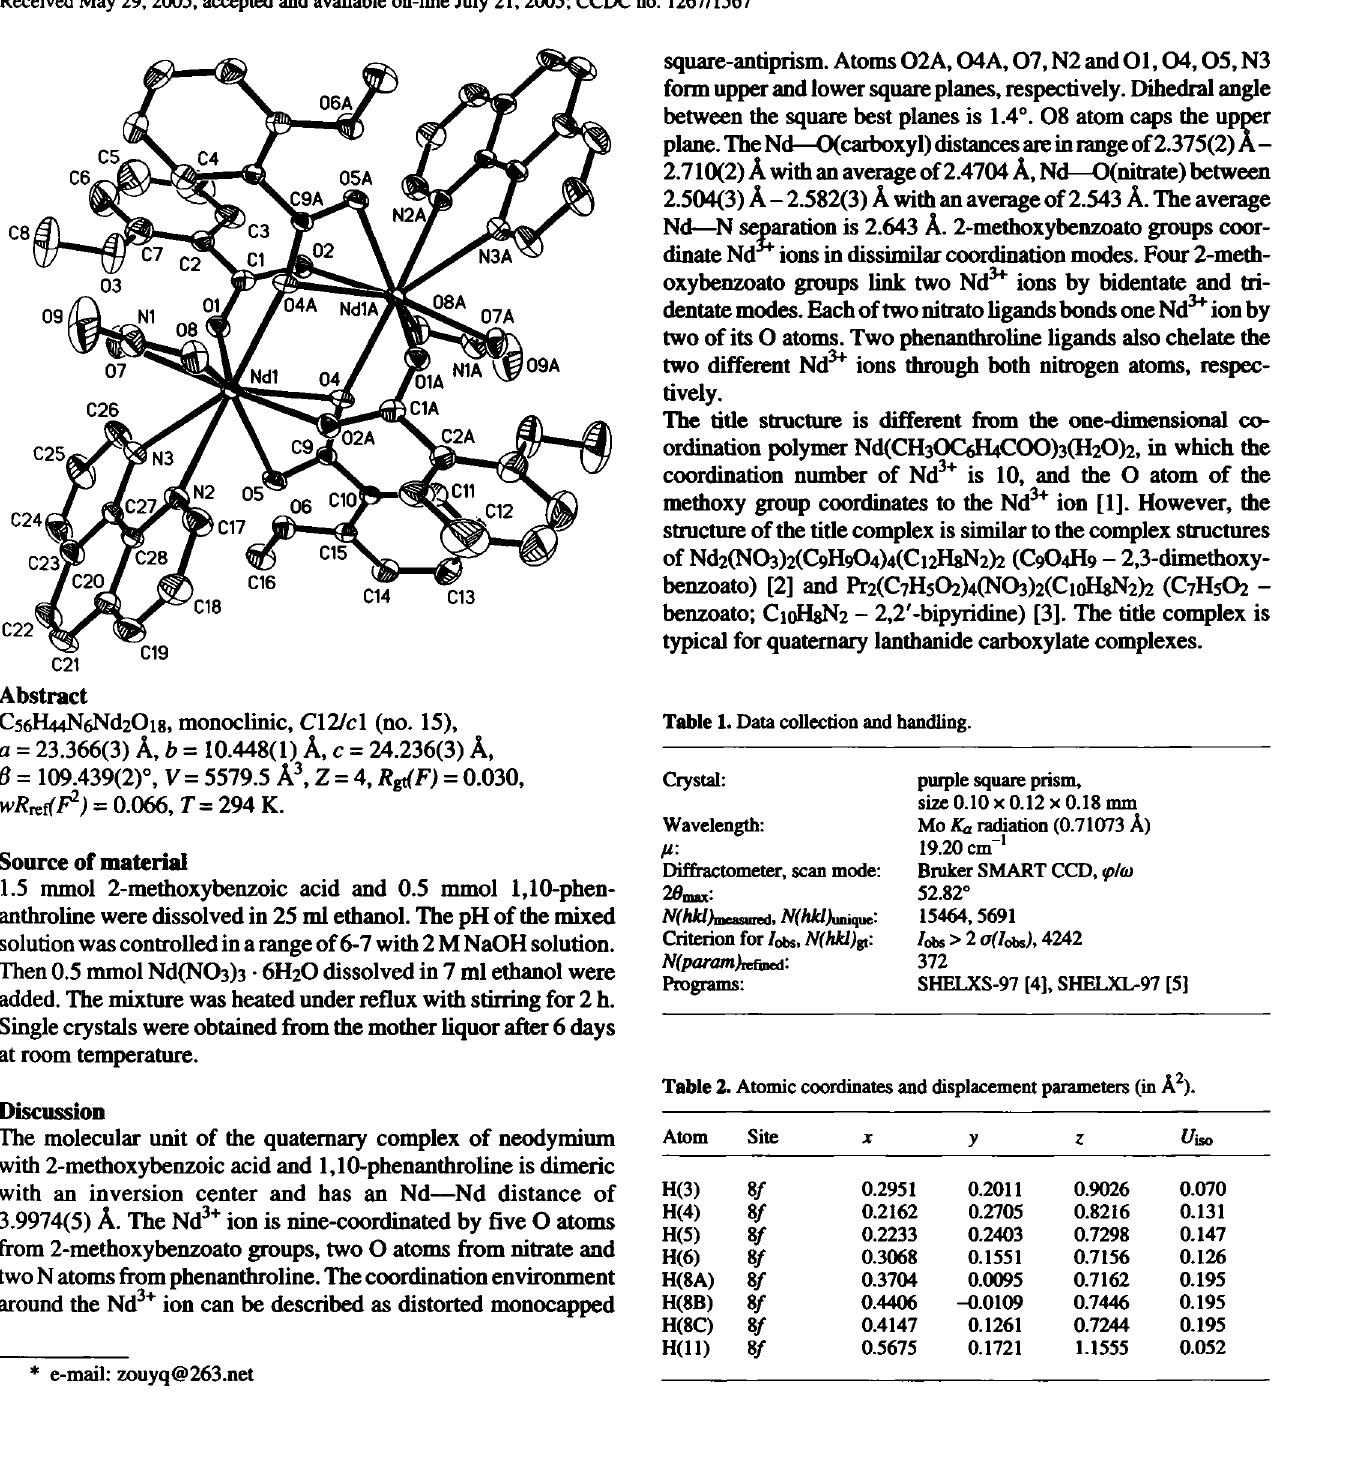
Table 2. Atomic coordinates and displacement parameters (in A 2